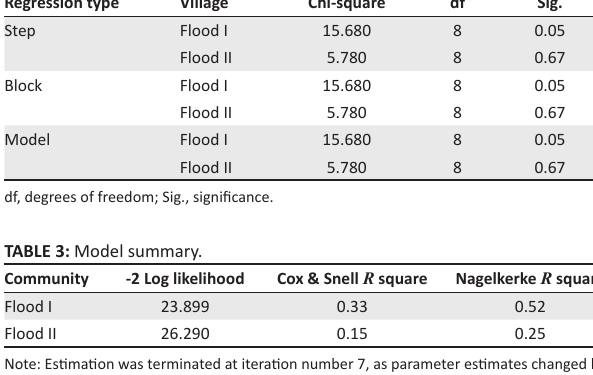
TABLE 2: Omnibus tests of model coefficients. Regression